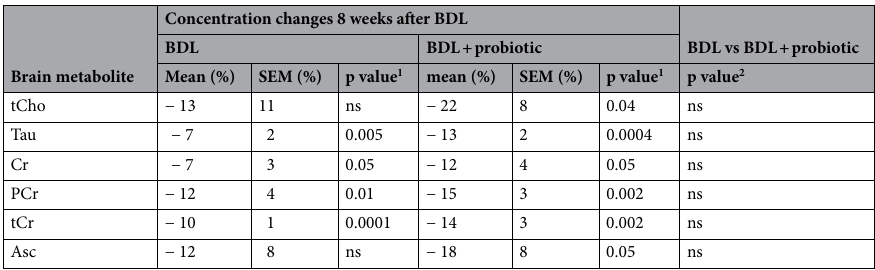
Table 3. Concentration changes of some brain metabolites 8 weeks after BDL surgery in BDL and BDL + probiotic groups. 1 One-way ANOVA repeated measure between concentrations of corresponding metabolite at week 0 and week 8 after BDL surgery. 2 One-way ANOVA between % changes of corresponding metabolite in BDL and BDL + probiotic